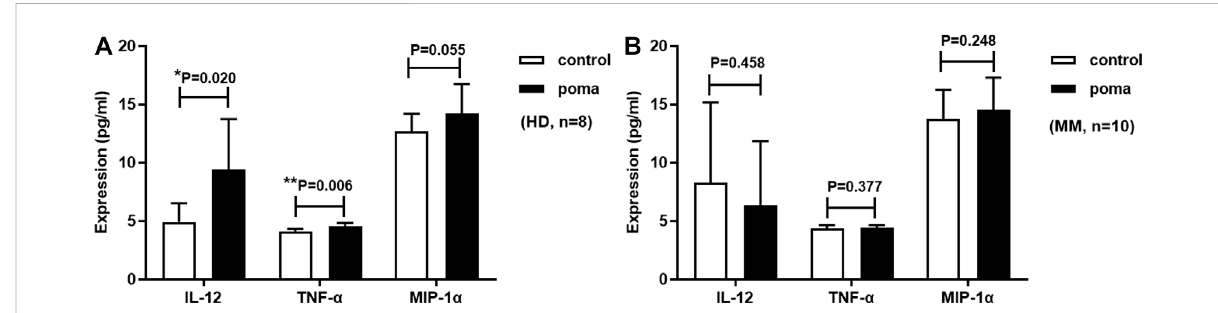
Pomalidomide affects moDC cytokine expression. (A) shows that the expression of IL-12 and TNF- α produced by pomalidomide treated HD- moDCs was signi fi cantly higher than untreated HD-moDCs ( n = 8). (B) shows that the expression of IL-12, TNF- α , and MIP-1 α from MM patient- moDCs showed no signi fi cant difference between the pomalidomide group and the control group ( n =